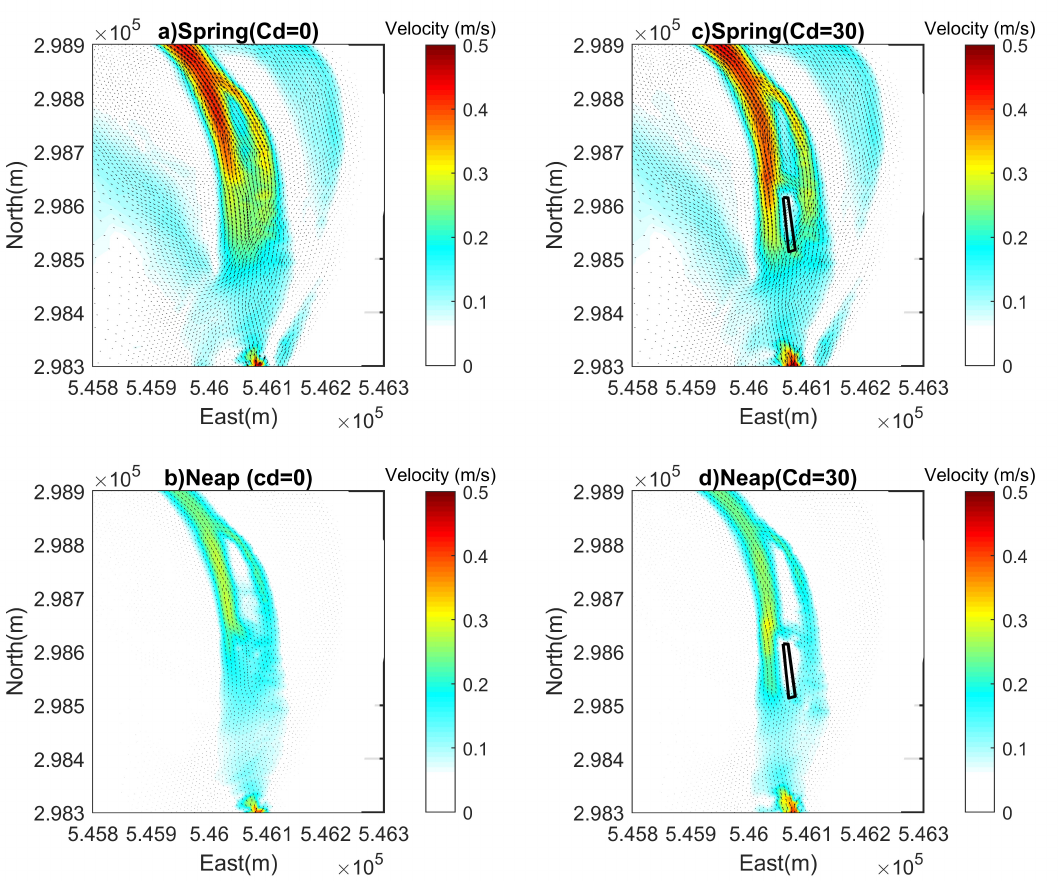
Figure 9. Residual current with and without the SND during spring tide ( a , c ) and during neap tide ( b , d ). The back lines depict the location of the SND.